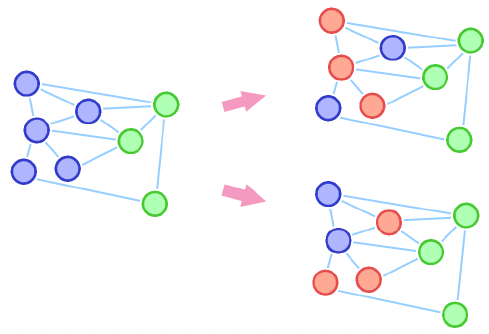
Figure 5. An example of two-batch generation for the mixed inductive–transductive learning setting. From the left: the original graph, with no transductive nodes; the generated batches, with both inductive and transductive nodes. Blue, red, and green nodes represent inductive drug nodes, transductive drug nodes, and gene nodes, respectively. Note that the transduction is performed only on drug nodes, since no prediction is performed on nodes belonging to a different type. Table 1. Hyperparameter search space for MolecularGNN. M = molecular embedding sub-model; D = DruGNN sub-model. In bold is the final architecture of the MolecularGNN model. Hyperparameter